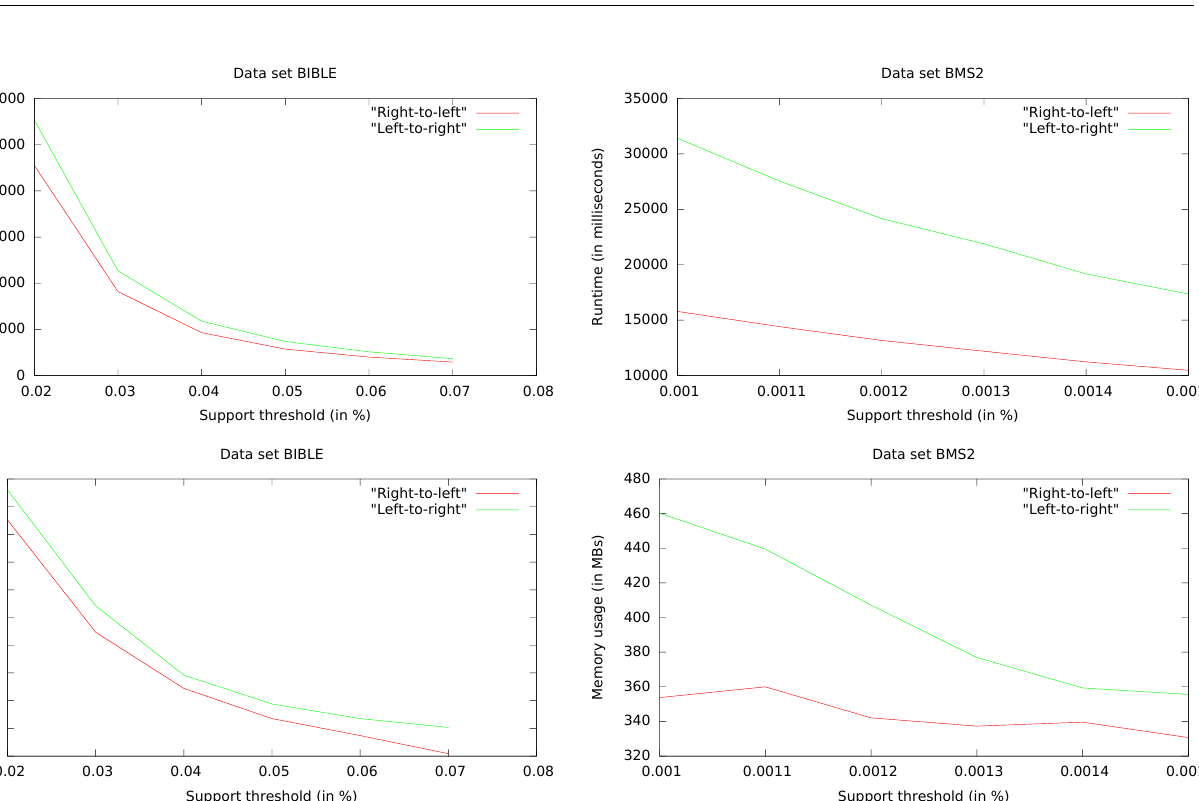
Figure 3. Performances of left-to-right and right-to-left pattern- growth orderings on the real-life data set BIBLE. The right-to-left pattern-growth ordering is 1 . 21 − 1 . 25 times faster and requires almost 1 . 04 − 1 . 10 times less memory than the other ordering.